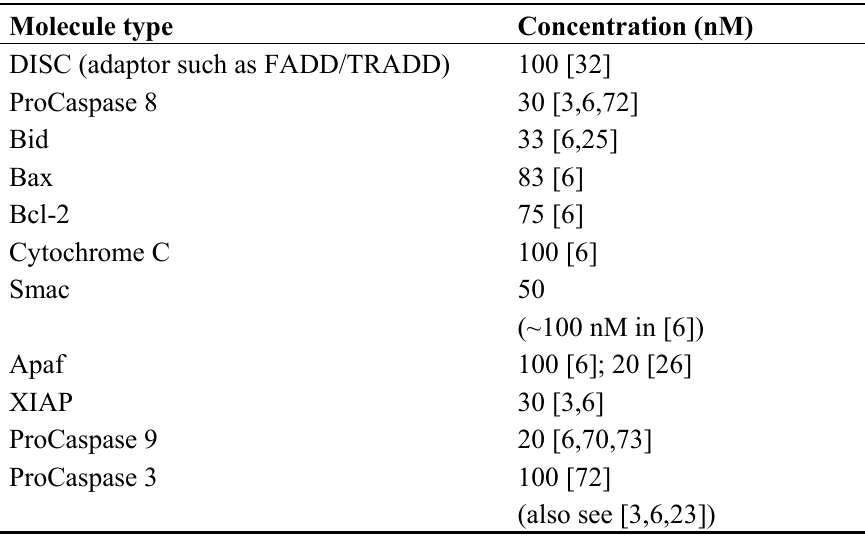
Table A2. Initial number of